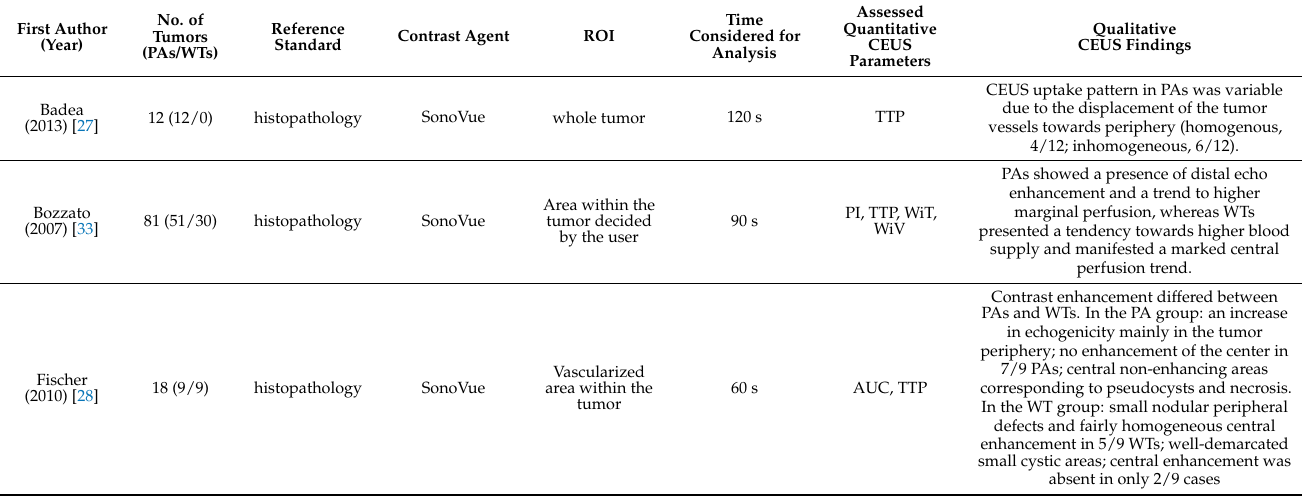
Table 1. Characteristics of included